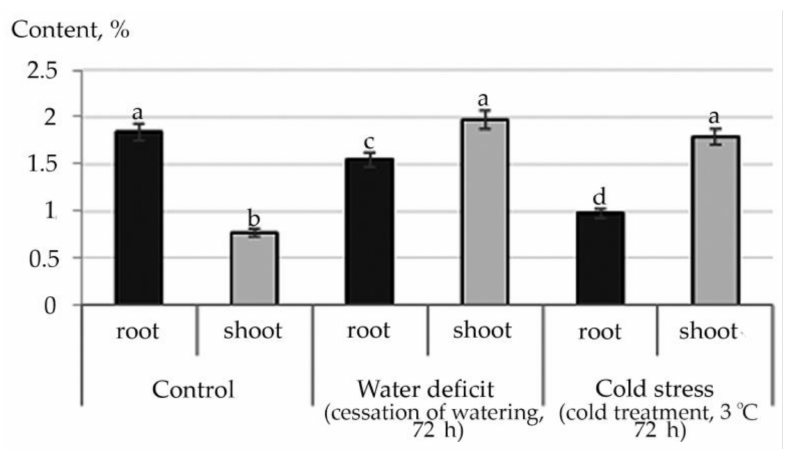
Figure 6. Change in the content of γ -Tocopherol in R. semenowii under stress conditions. Values presented are means ( ± SD). Different letters above the bars represent significant differences at p ≤ 0.05, n = 3 plants in each of 3 replicates for all treatments.